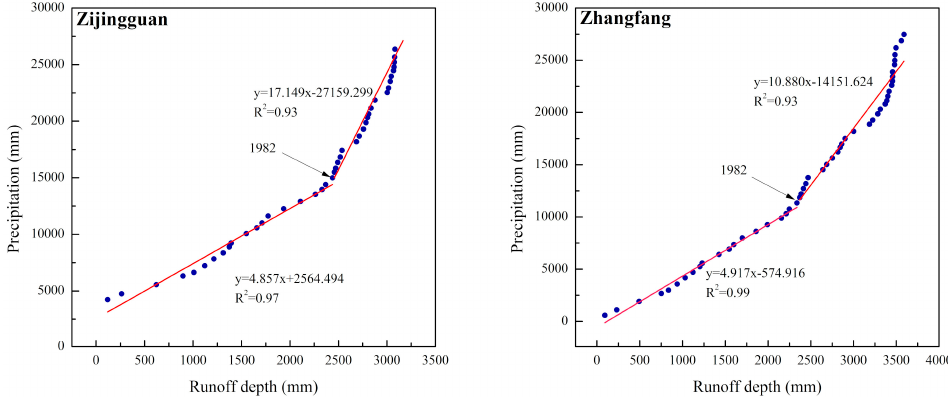
Figure 6. The double cumulative curve for the precipitation and runoff of two stations.